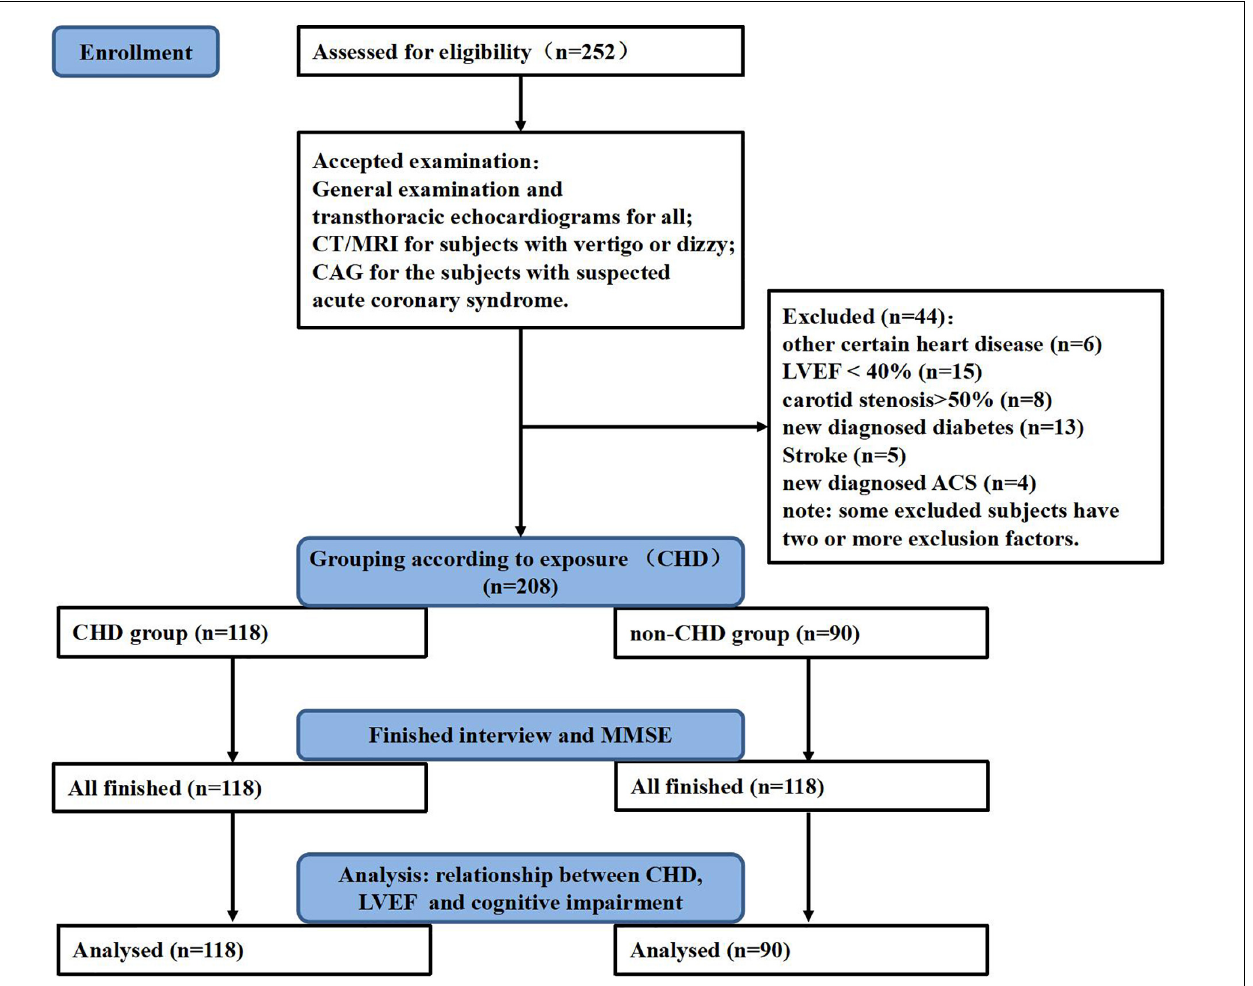
FIGURE 1 | Study flowchart. General examination includes an electrocardiogram (ECG), cardiac enzymes, high sensitive cardiac Troponin I, carotid artery ultrasonography, and other routine examination. CHD, coronary heart disease; MMSE, mini-mental state examination; LVEF, left ventricular ejection fraction;